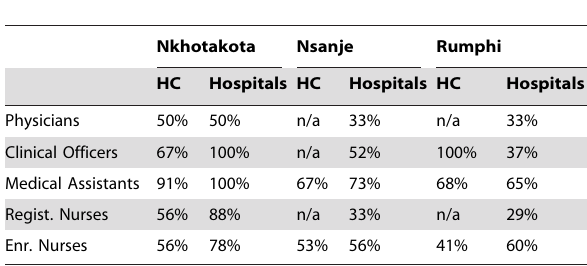
Table 3. Percentage of expected positions filled by district and hc/hospitals (expected positions based on facility managers’ and District Health Offices’ information); HC n= 45, hospitals n=